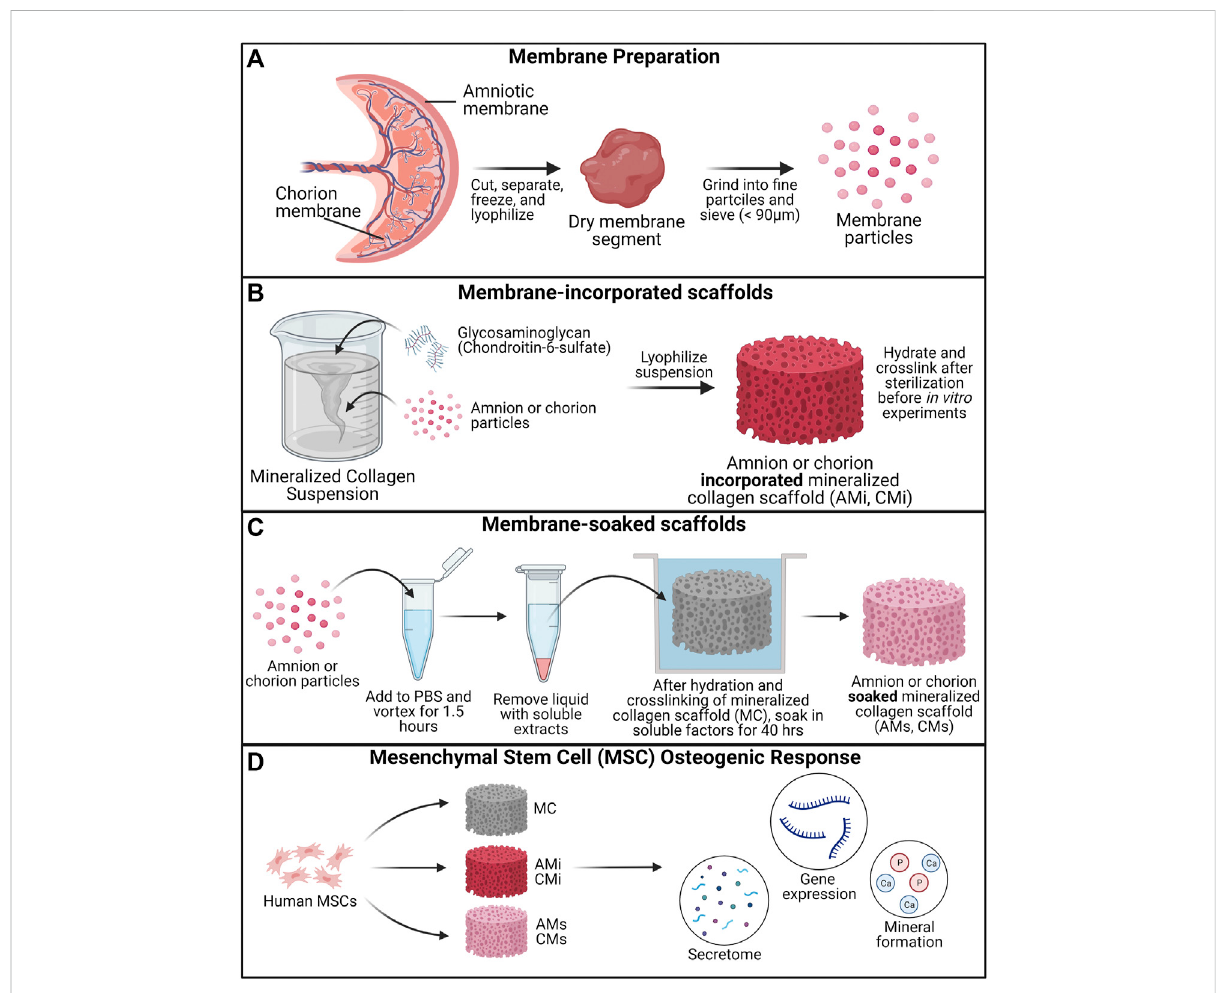
FIGURE 1 Experimental Outline. (A) Placental derived amnion and chorion membranes were harvested, decellularized and pulverized into fi ne particles ( < 90 μ m diameter). Mineralized collagen scaffold variants were fabricated into: amnion or chorion incorporated or soaked. (B) Mineralized collagen — amnion or chorion incorporated scaffolds were fabricated by adding amnion or chorion particles during the scaffold fabrication. (C) To fabricate the soaked variants mineralized collagen scaffolds soaked in a media suspension containing amnion or chorion extracts. (D) Human mesenchymal stem cells were seeded on scaffolds and allowed to culture for 21 days. hMSC osteogenesis and immunomodulatory potential was determined through the evaluation of the genomic and proteomic expression and degree of mineral